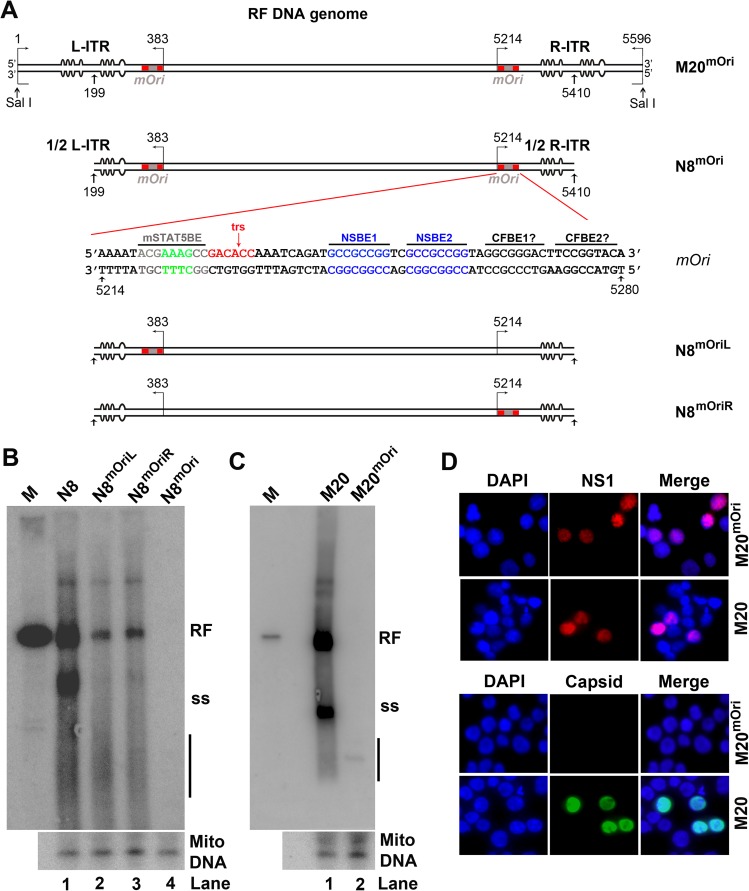
Failure of B19V replicative form DNA clones with STAT5-binding element mutations in replication in transfected UT7/Epo-S1 cells.(A) Diagram of the B19V full-length M20 RF genome and various half ITR-deleted N8 RF genomes with mutations at STAT5-binding elements (STAT5BEs). Red squares indicate the position of the Ori sequences at both ITRs, and grey squares indicate mutated Ori (mOri). The sequence of the mOri is shown with mutated nucleotides in grey in the STAT5BE. (B&C) Southern blot analysis. (B) The N8 RF DNA, or derivatives with mutations in the STAT5BE of either the left ITR (N8mOriL), right ITR (N8mOriR), or both (N8mOri), were transfected into UT7/Epo-S1 cells. (C) M20, and M20mOri, a derivative of the M20 RF DNA with STAT5BEs of both ITRs mutated, were transfected into UT7/Epo-S1 cells. At 48 h post-transfection, cells were collected for Hirt DNA extraction. And Hirt DNA samples were analyzed by Southern blotting with an M20 DNA probe. RF DNA (RF), ssDNA (ss), and Dpn I-digested DNA (shown with a line) are indicated. Mitochondrial DNA (Mito DNA) was used as a loading control (lower panels). (D) Viral protein expression of B19V DNA mutants. M20 or M20mOri transfected UT7/Epo-S1 cells were stained with anti-NS1 or anti-capsid antibodies. Confocal images were taken with an Eclipse C1 Plus (Nikon) microscope at 100 × magnification.